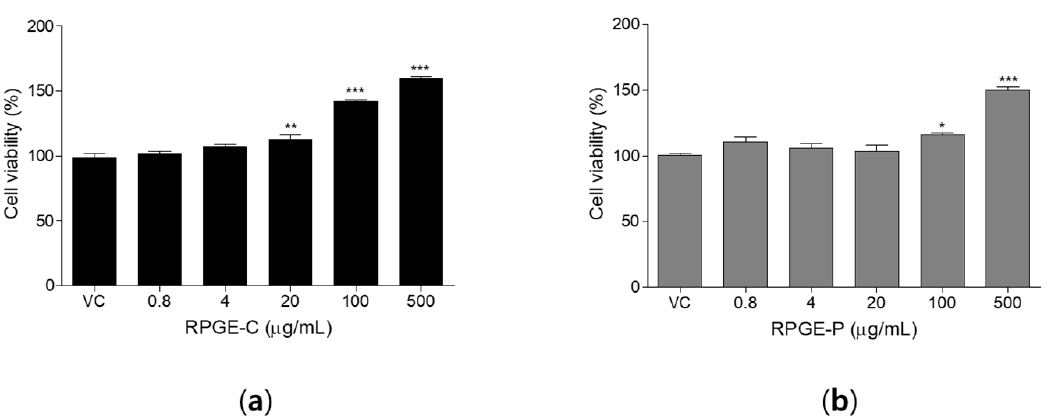
Figure 1. Effect of Red Platycodon Grandiflorus Root Extract (RPGE) on cell viability in RAW 264.7 cells. (a) RPGE-concentrate (RPGE-C); (b ) RPGE-powder (RPGE-P). The results are expressed as relative values to that of the vehicle-treated cells (vehicle control, VC), which is set to 100%. The data are represented as the mean ± SEM. *p < 0.05, **p < 0.01, and ***p < 0.001 when compared with the VC.